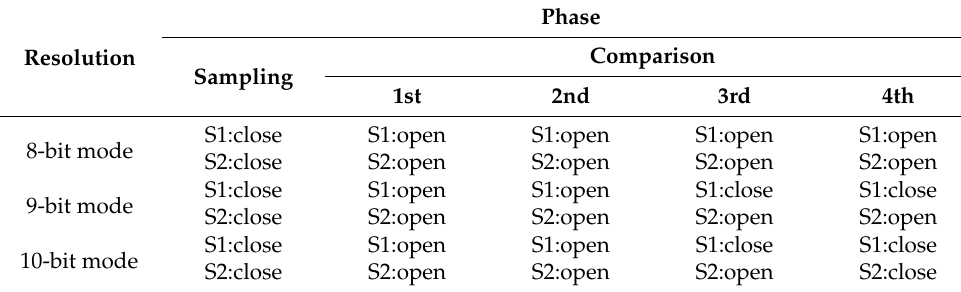
Table 2. Resolutions of ADC are adjusted by S1 and S2.